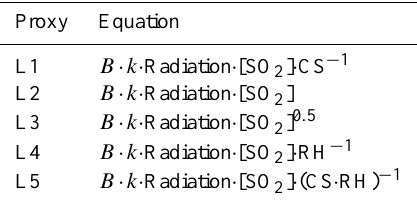
Table 3. Proxy functions for the linear fitting